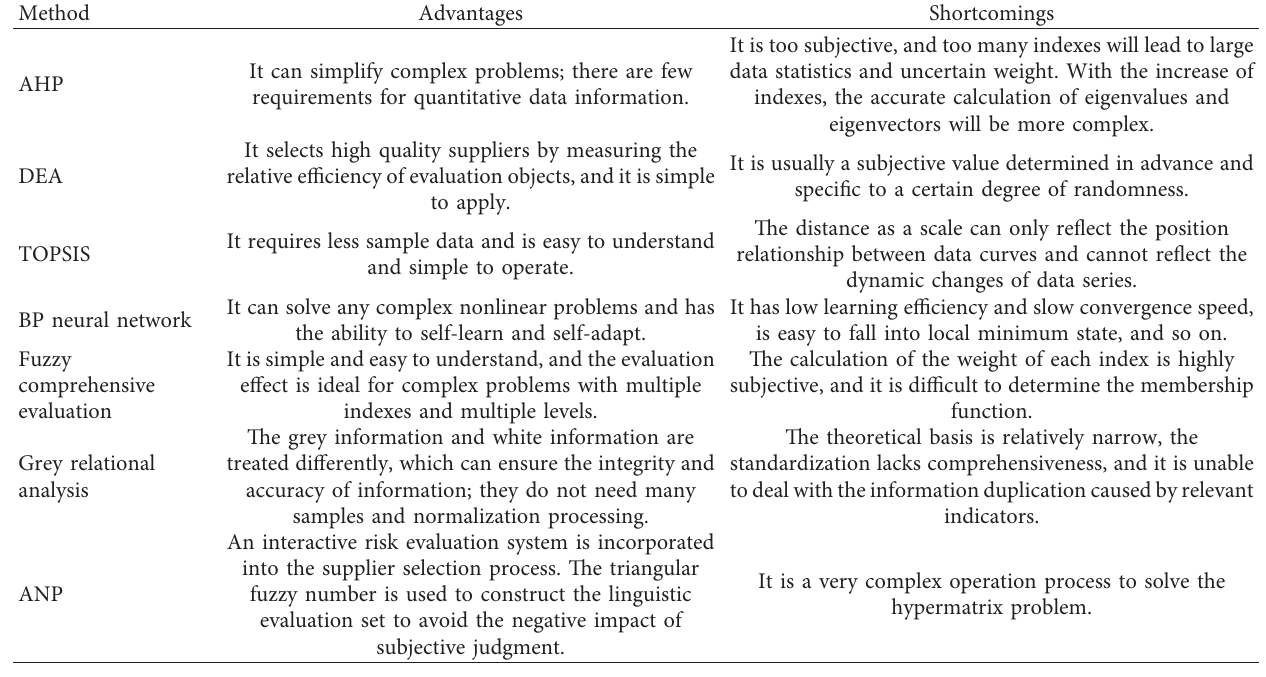
Table 1: Summary of LSPs evaluation